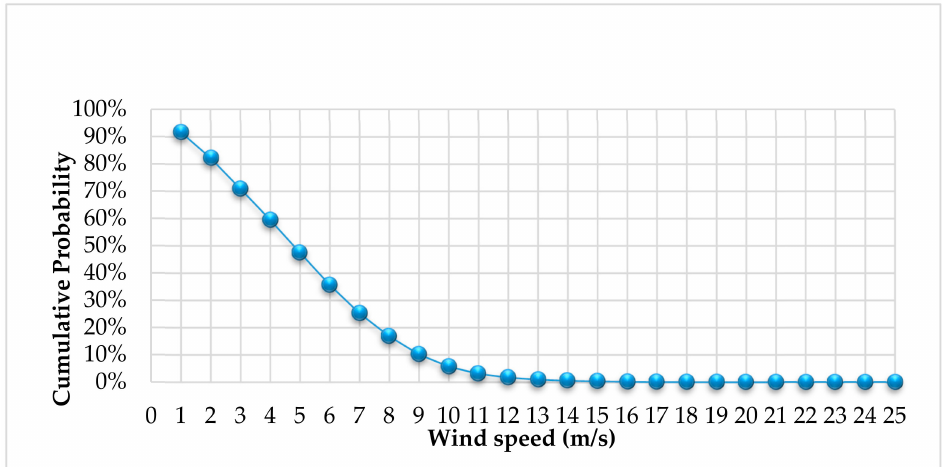
Figure 12. Cumulative data